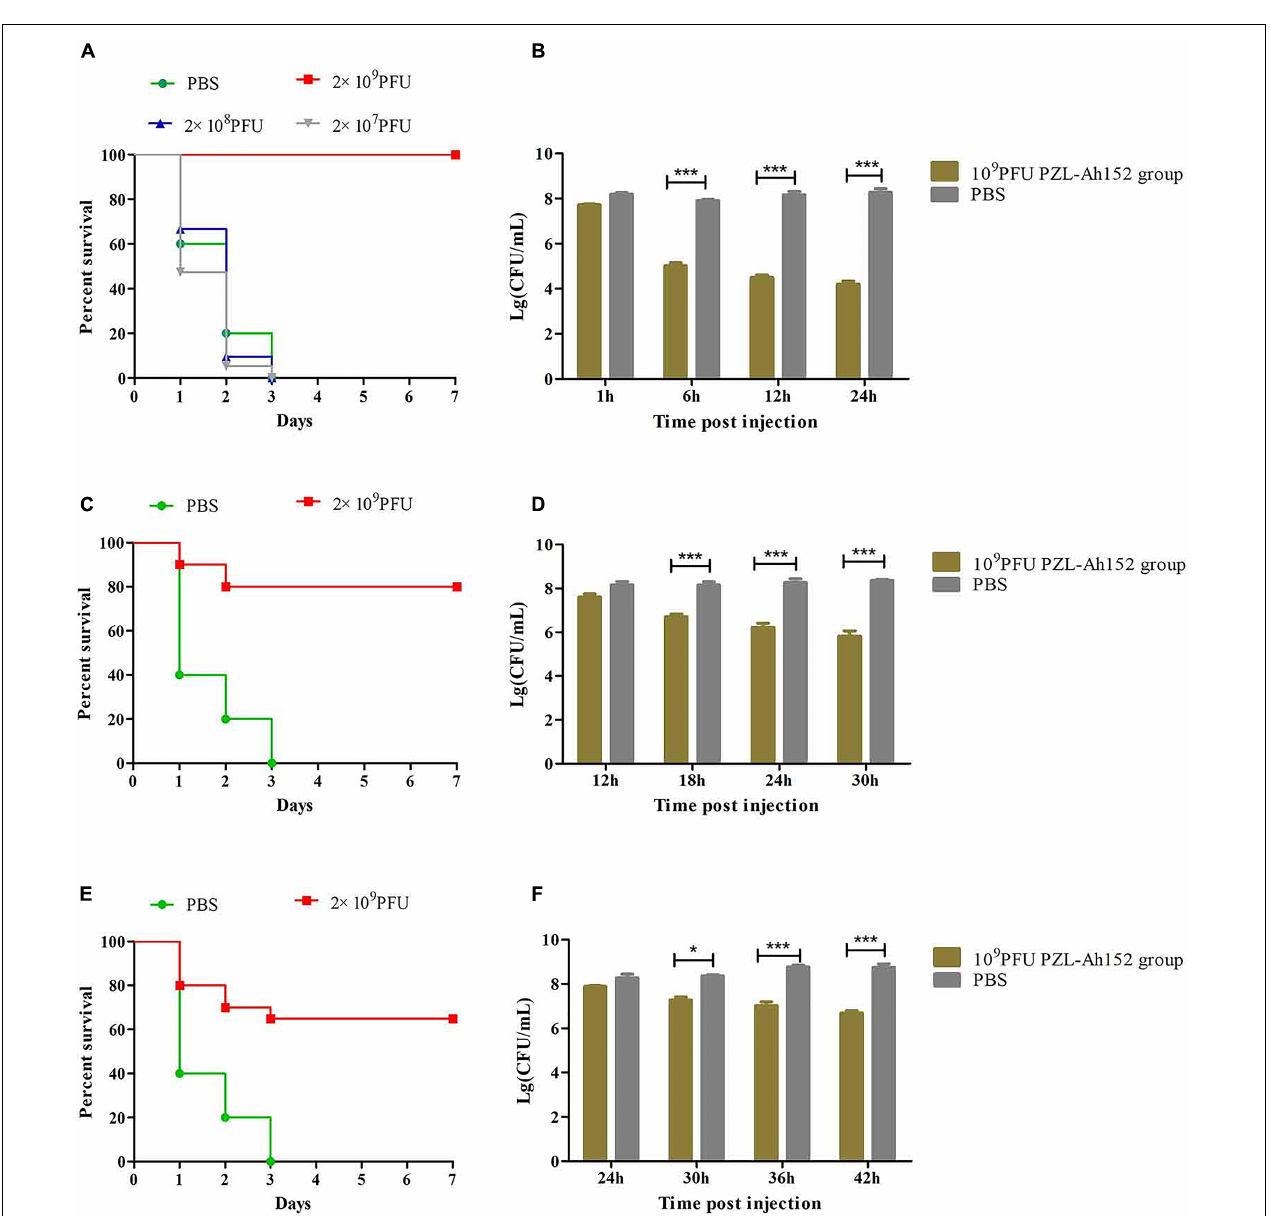
FIGURE 7 | PZL-Ah152 therapeutic study. The fish were intraperitoneally injected with 2 × minimum lethal doses (MLD) (2 × 10 8 CFU/fish) of A. hydrophila -152. (A,C,E) Survival rate of different groups. One hours later, 10 7 , 10 8 , and 10 9 PFU of PZL-Ah152 were introduced intraperitoneal (A) . After injection of A. hydrophila -152 (2 × 10 8 CFU/fish) 12 h later (C) , 24 h later (E) , 2 × 10 9 PFU phage of PZL-Ah152 were introduced intraperitoneal. Control fish were administrated with PBS under the identical conditions. (B,D,F) Colony counts of bacteria changed in the gut. After injection of A. hydrophila -152 (2 × 10 8 CFU/fish) 1 h later (B) , 12 h later (D) , 24 h later (F) . Colony counts of bacteria changed in the gut at regular intervals ( n = 6 in each group). Control fish were administrated with PBS under the identical conditions. The means and standard deviations are represented as points with error bars. * p < 0.05, *** p <